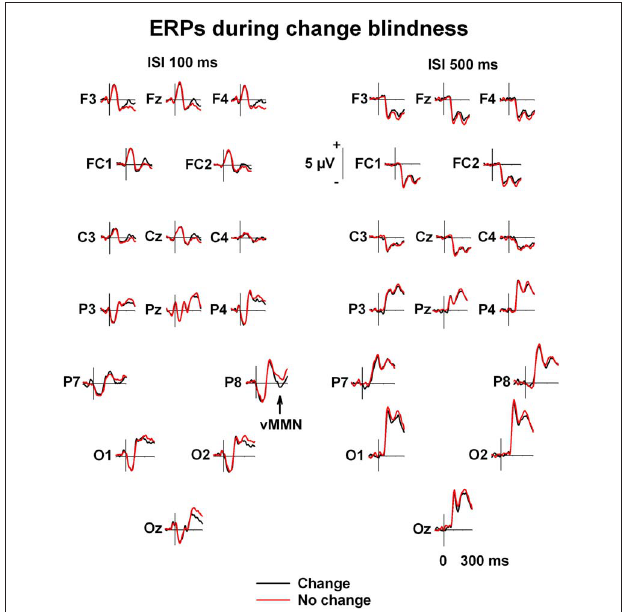
FIGURE 3 | Grand averaged ERPs. Grand-averaged ERPs to image with changes (black line) and images without changes (red line) during change blindness.